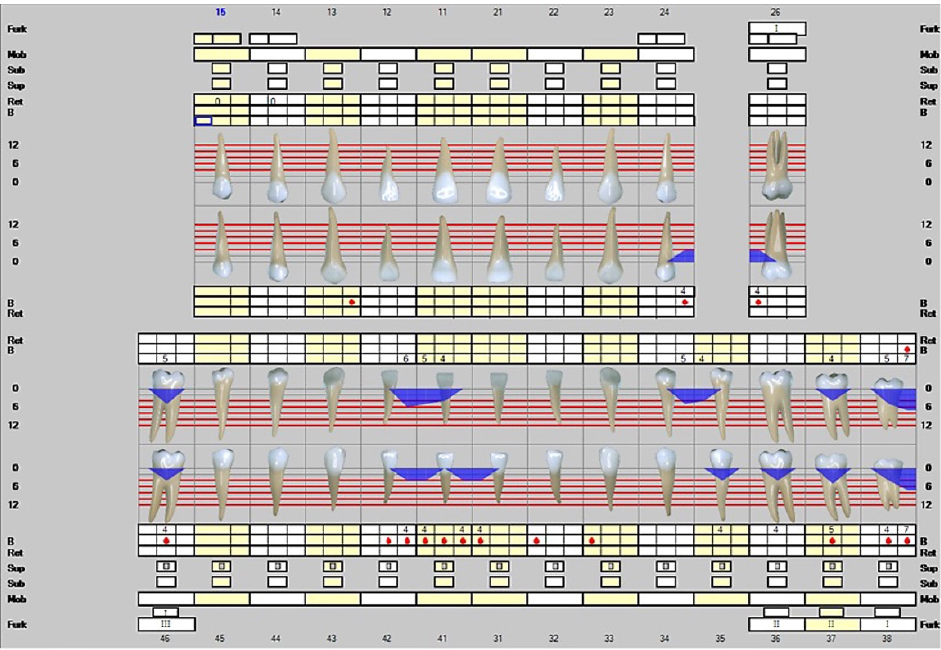
Figure 3. Representation of the clinical situation on 27 January 2022. The white line describes the clinical attachment level and the blue color plaque-infested periodontal pockets. The red dots represent a positive result in bleeding on probing. A total of eight teeth with a minimum of 4 mm pocket depths showed no pockets at all. In addition, the overall clinical attachment level improved significantly.